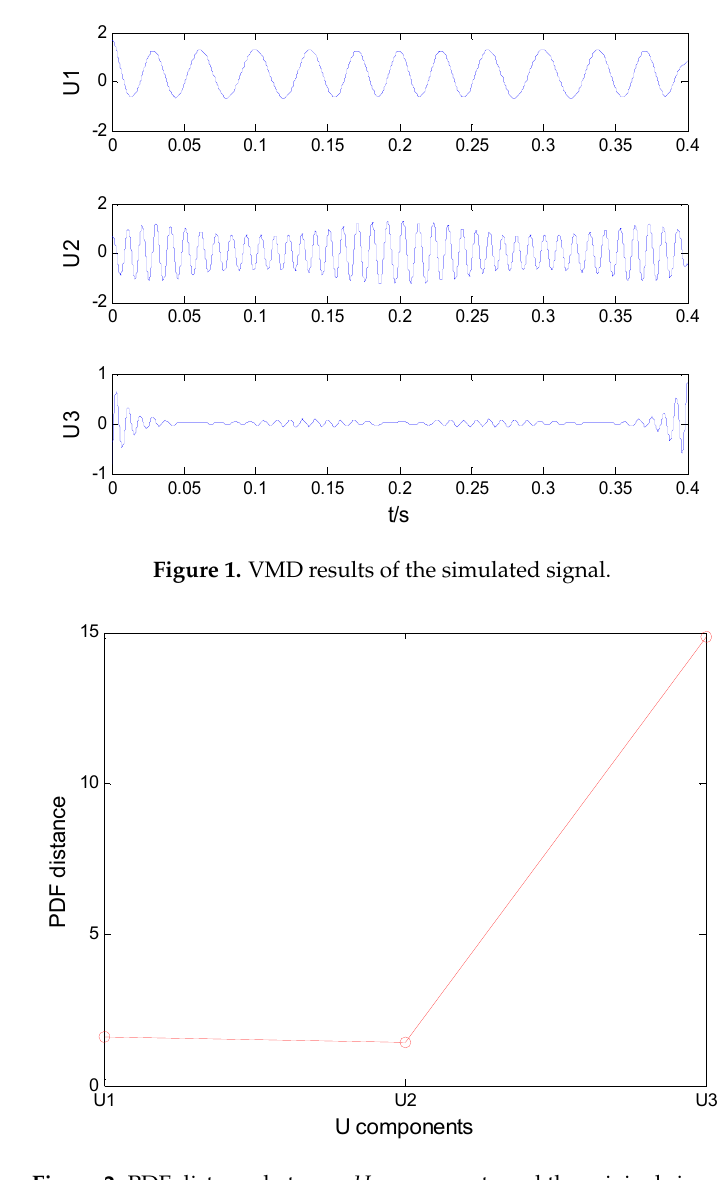
Table 1. MSE and SNR of simulated